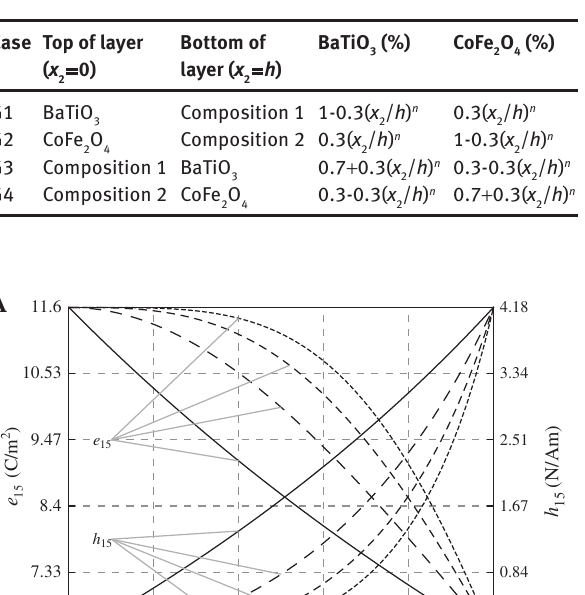
Table 3: Variations of volume fractions of constituent phases for each